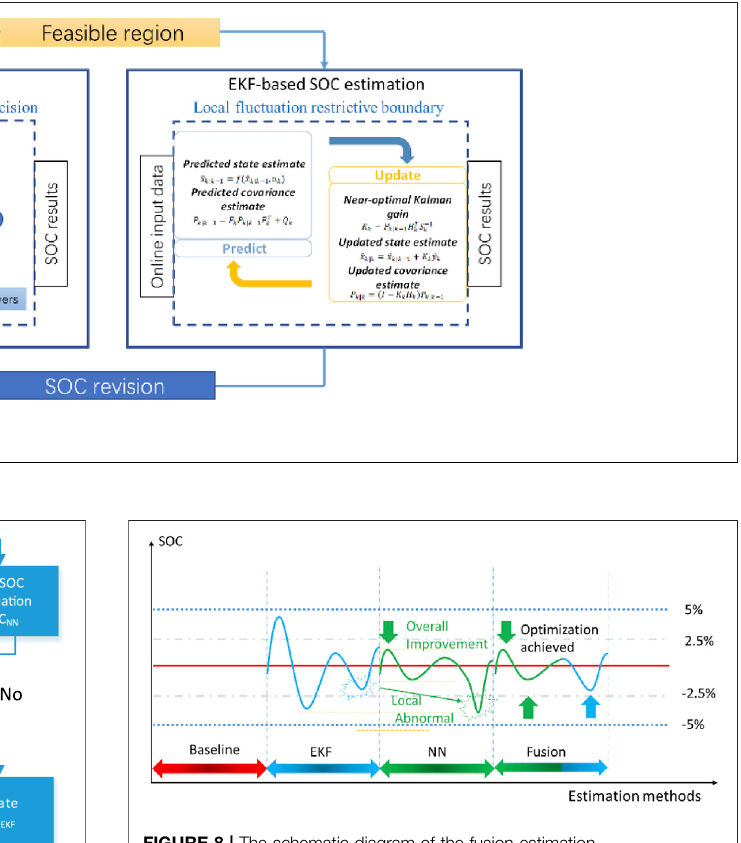
FIGURE 8 | The schematic diagram of the fusion